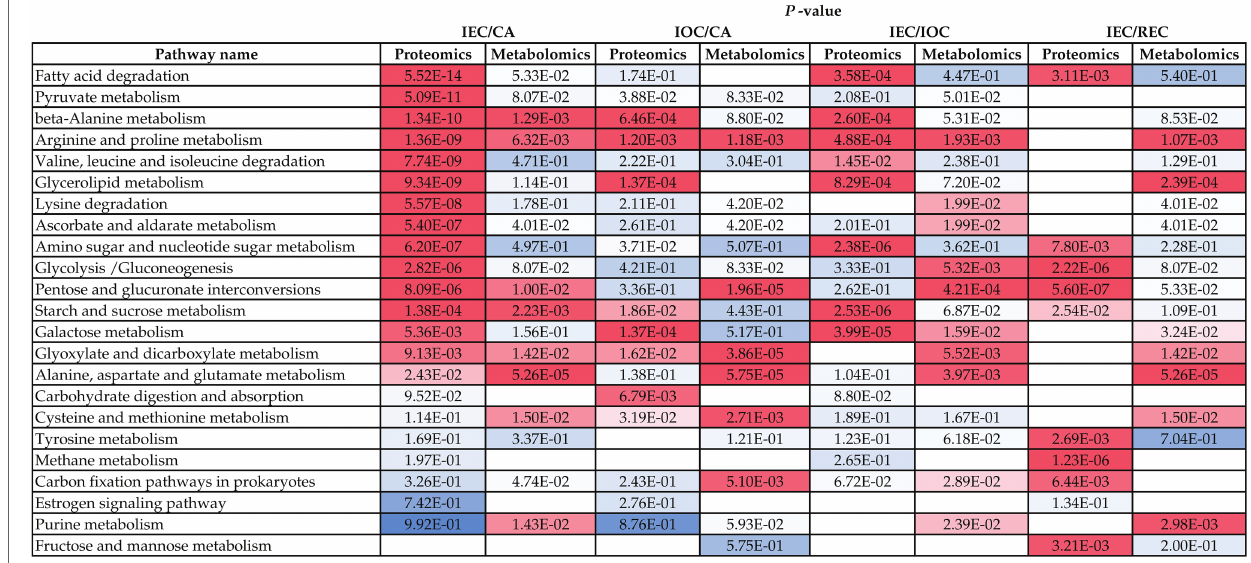
FIGURE 6 | Proteins and metabolites involved in common pathways related to cell differentiation. Data are p -values. Colors from red to blue indicate the p -value from low to high, and blank space mean not being enriched in KEGG